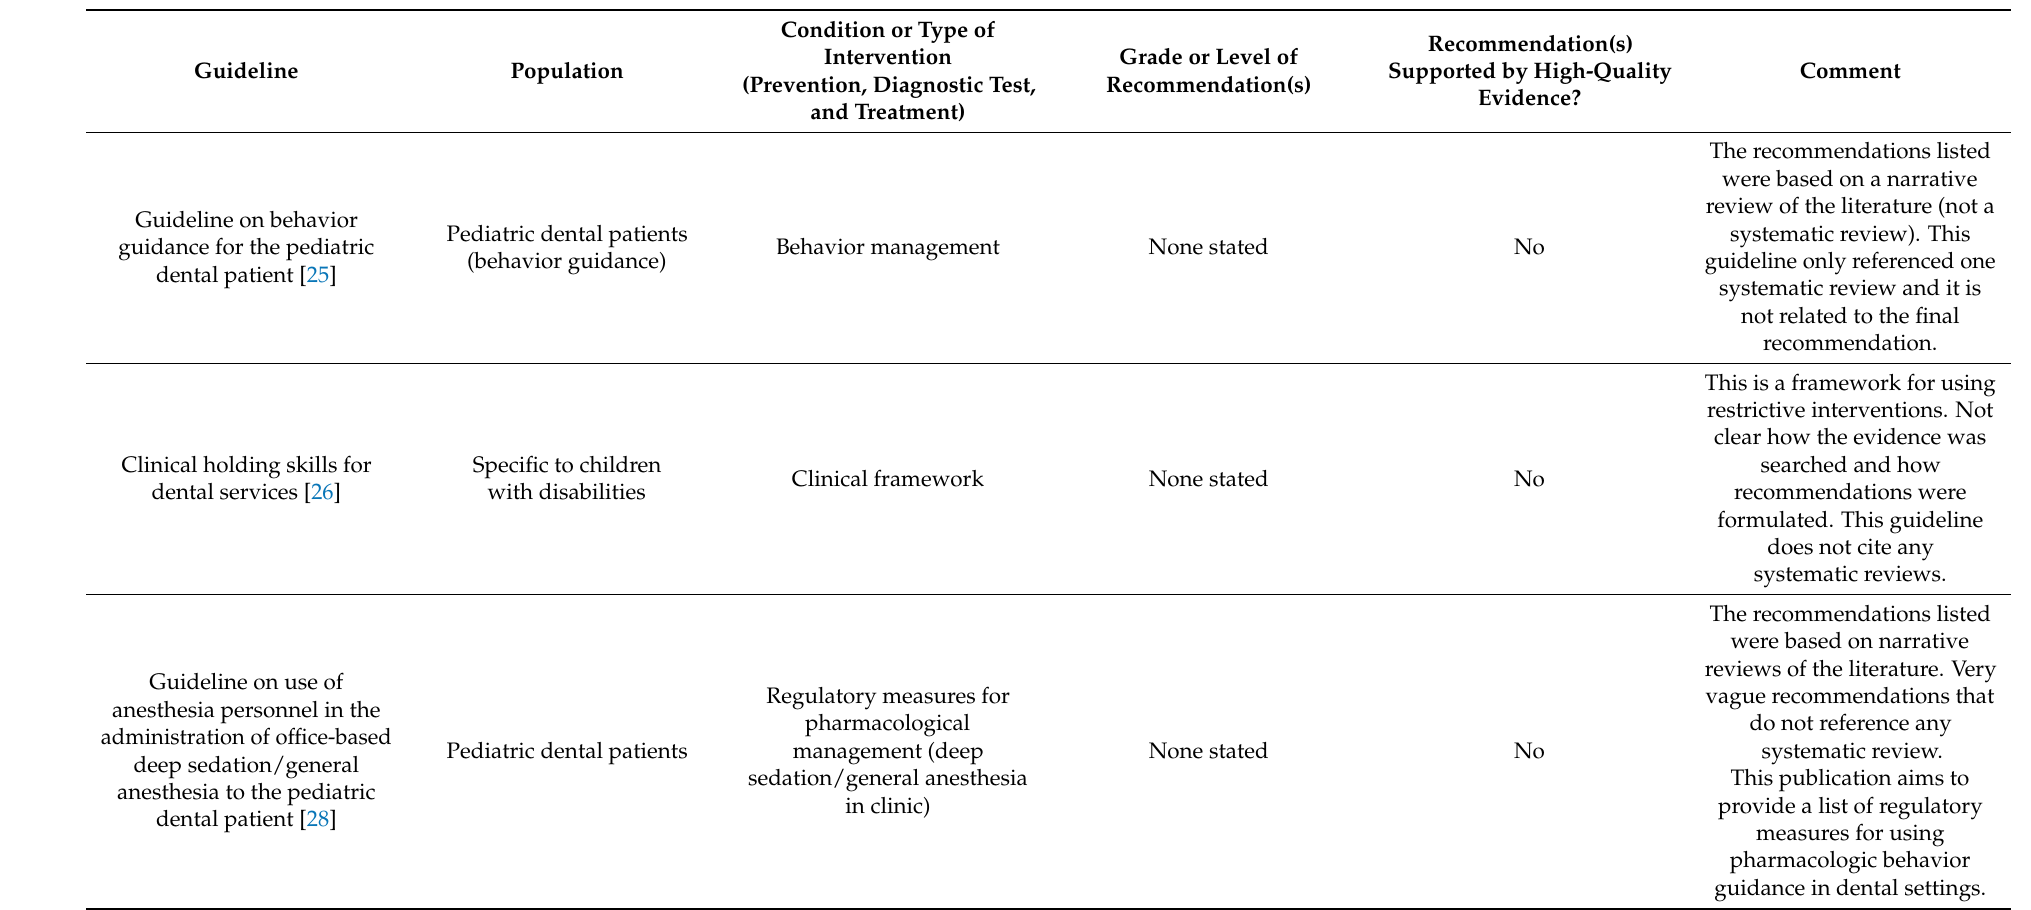
Table 4. Baseline characteristics for the